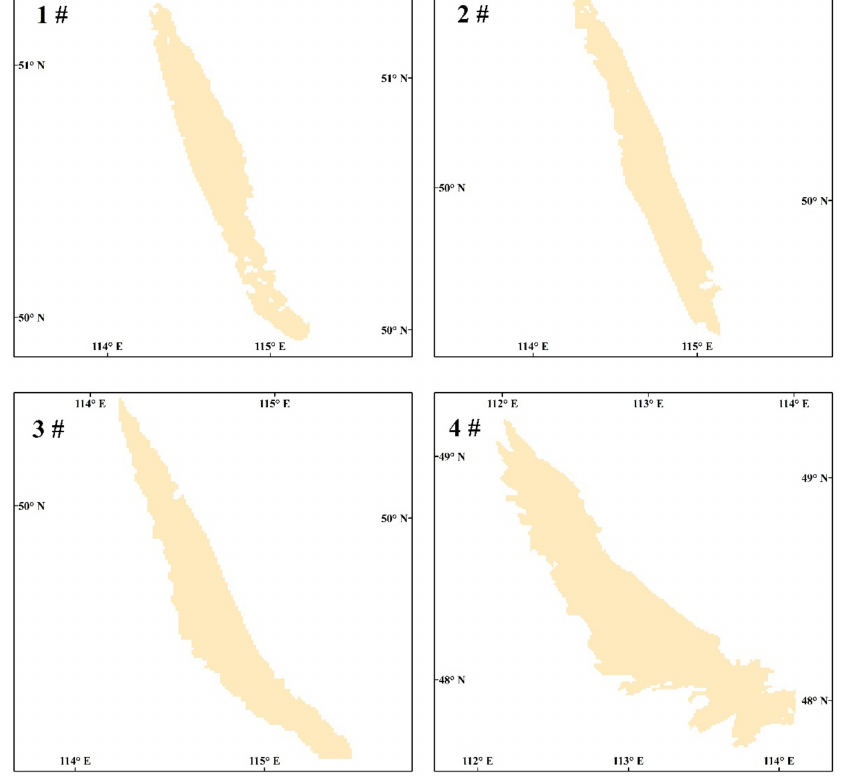
Figure 2. Smoke plumes detection using MODIS band